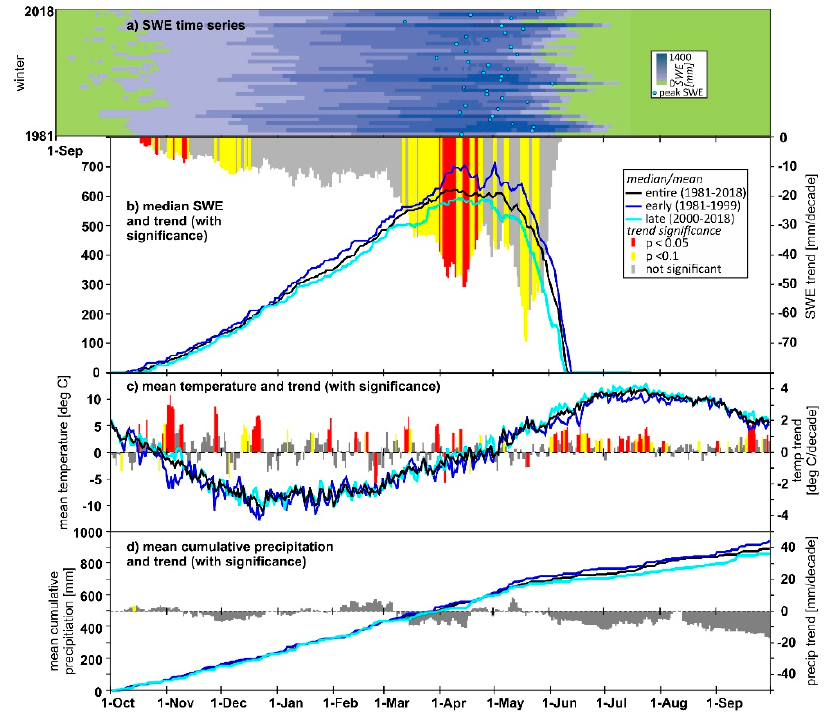
Figure 2. Lake Irene SNOTEL station ( a ) SWE time series for each year from 1981 to 2018 and the inter-annual autocorrelation (red line), ( b ) median SWE, ( c ) mean temperature, and ( d ) mean cumulative precipitation, all for entire period of record plus first and last half of the period of record. The SWE time series ( a ) starts in September to illustrate that snow does fall and occasionally accumulates prior to the start of the water year, October 1.